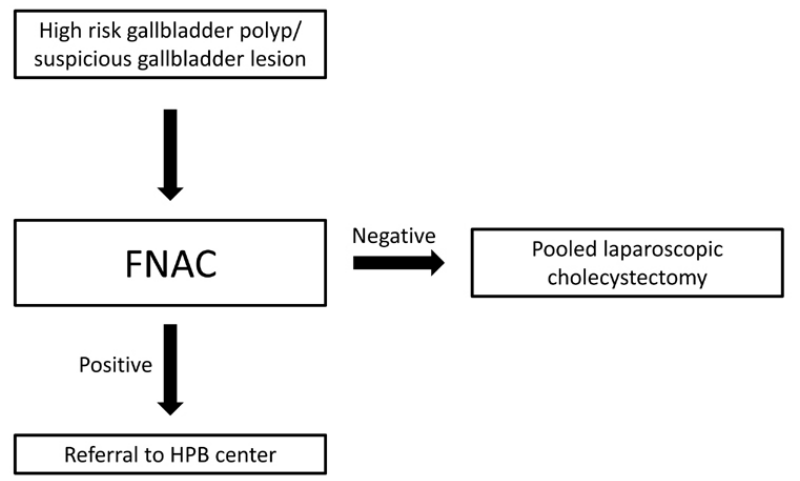
Figure 5. The suggested “Cardiff-Thessaloniki” modification to the management of high-risk gallbladder polyps and/or suspicious gallbladder lesions. bladder polyps and/or suspicious gallbladder